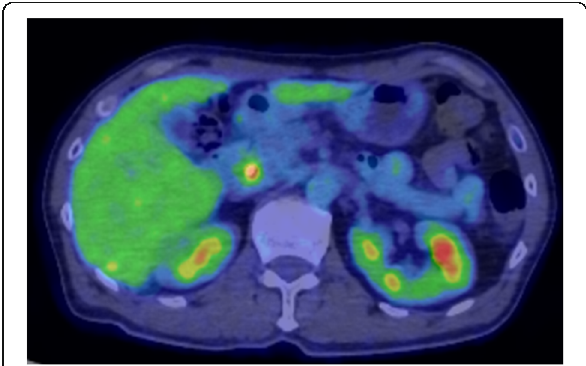
Fig. 2 Positron emission tomography-computed tomography scan image. The tumor exhibited uptake of